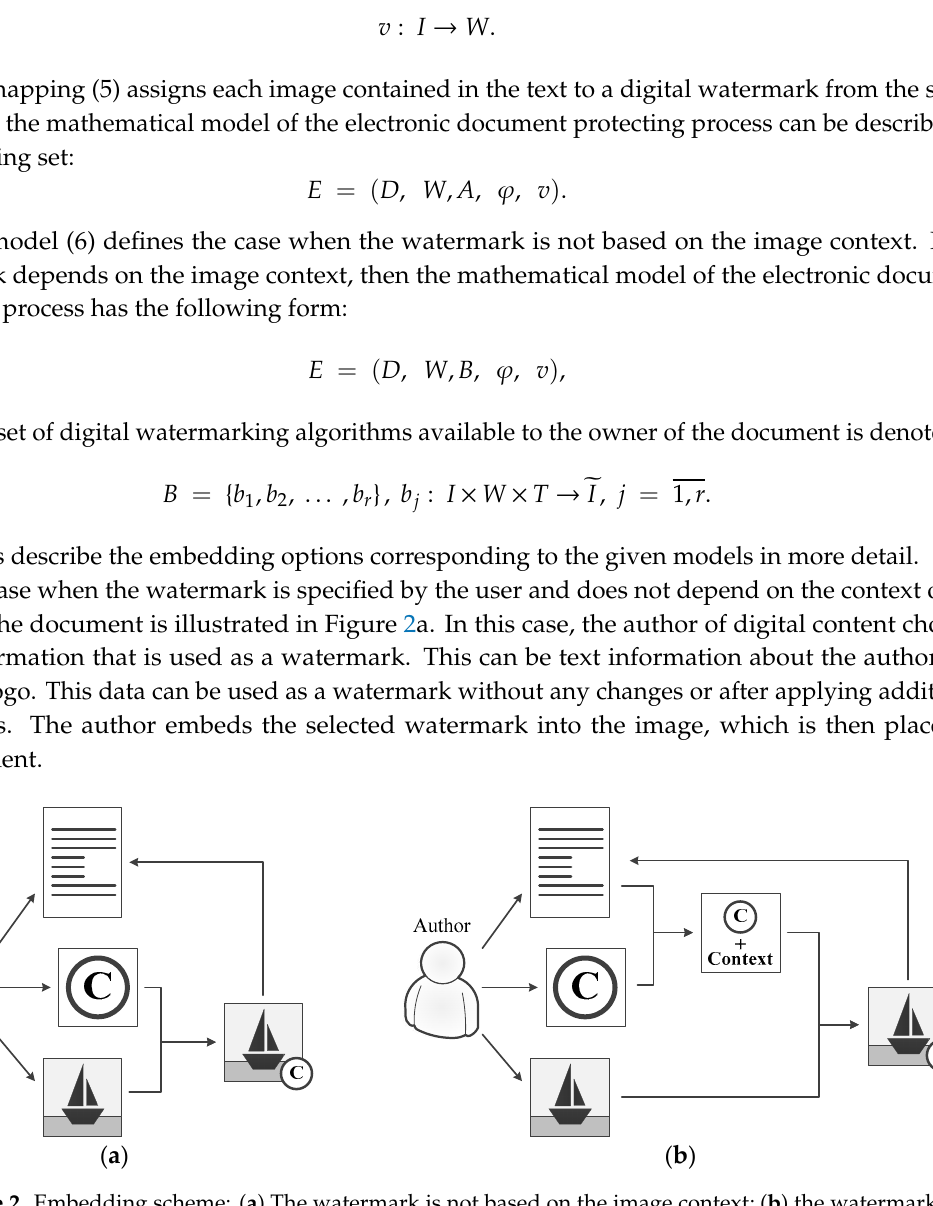
Figure 2. Embedding scheme: ( a ) The watermark is not based on the image context; ( b ) the watermark is based on the image context.